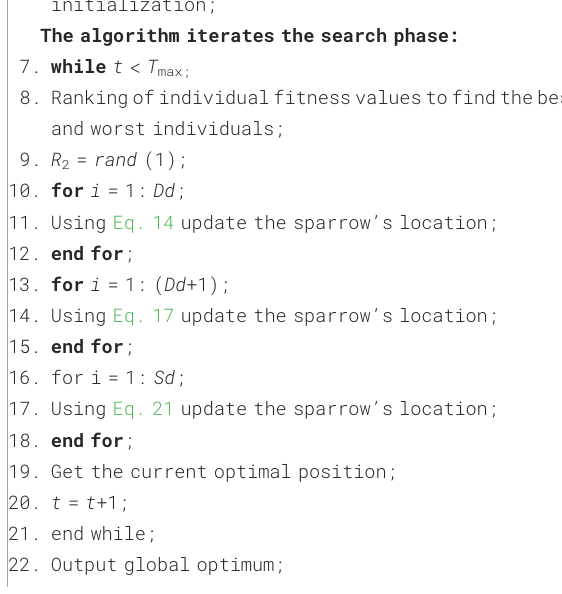
Algorithm 1. The framework of the MSSA.